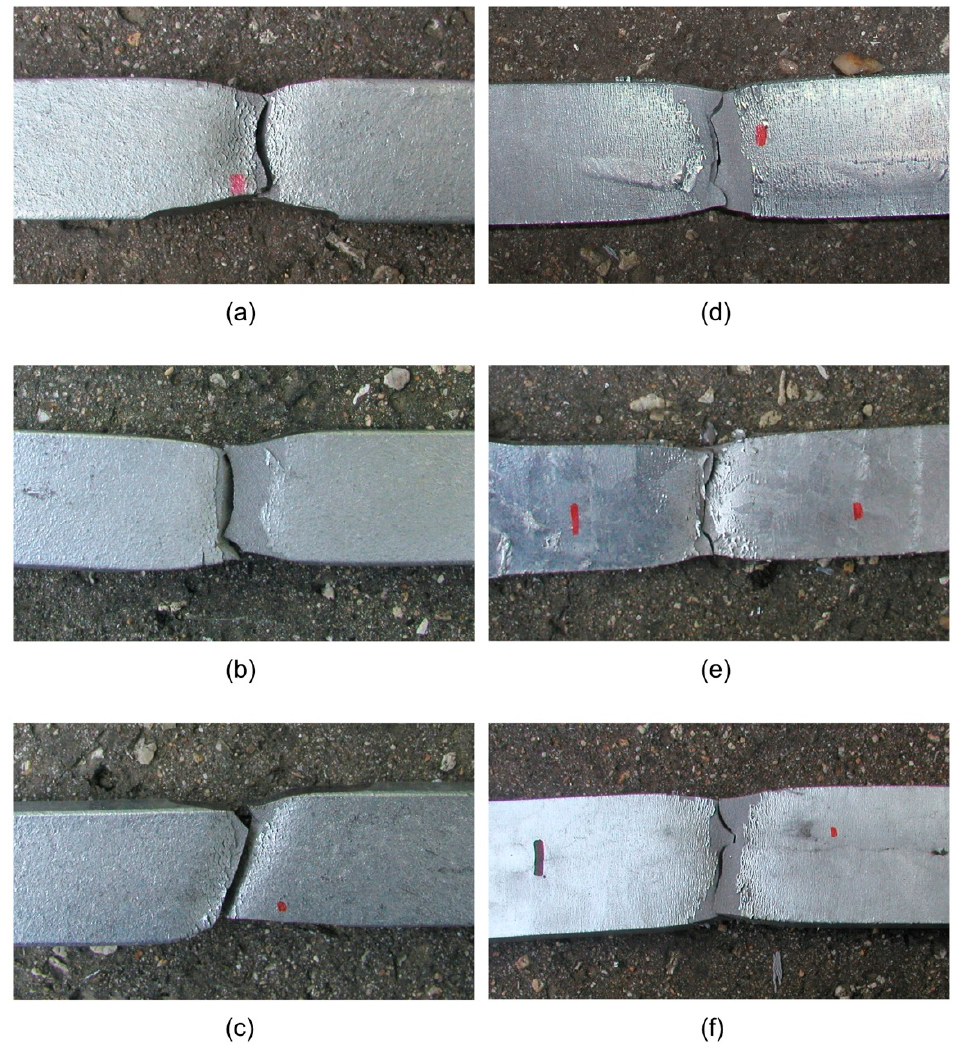
Figure 4. Tested hot-dip-galvanized specimens after the tensile tests were performed: ( a ) DOMEX 460, ( b ) DOMEX 550, ( c ) DOMEX 700, ( d ) HARDOX 500, ( e ) HARDOX 600, and ( f ) ARMOX 500.